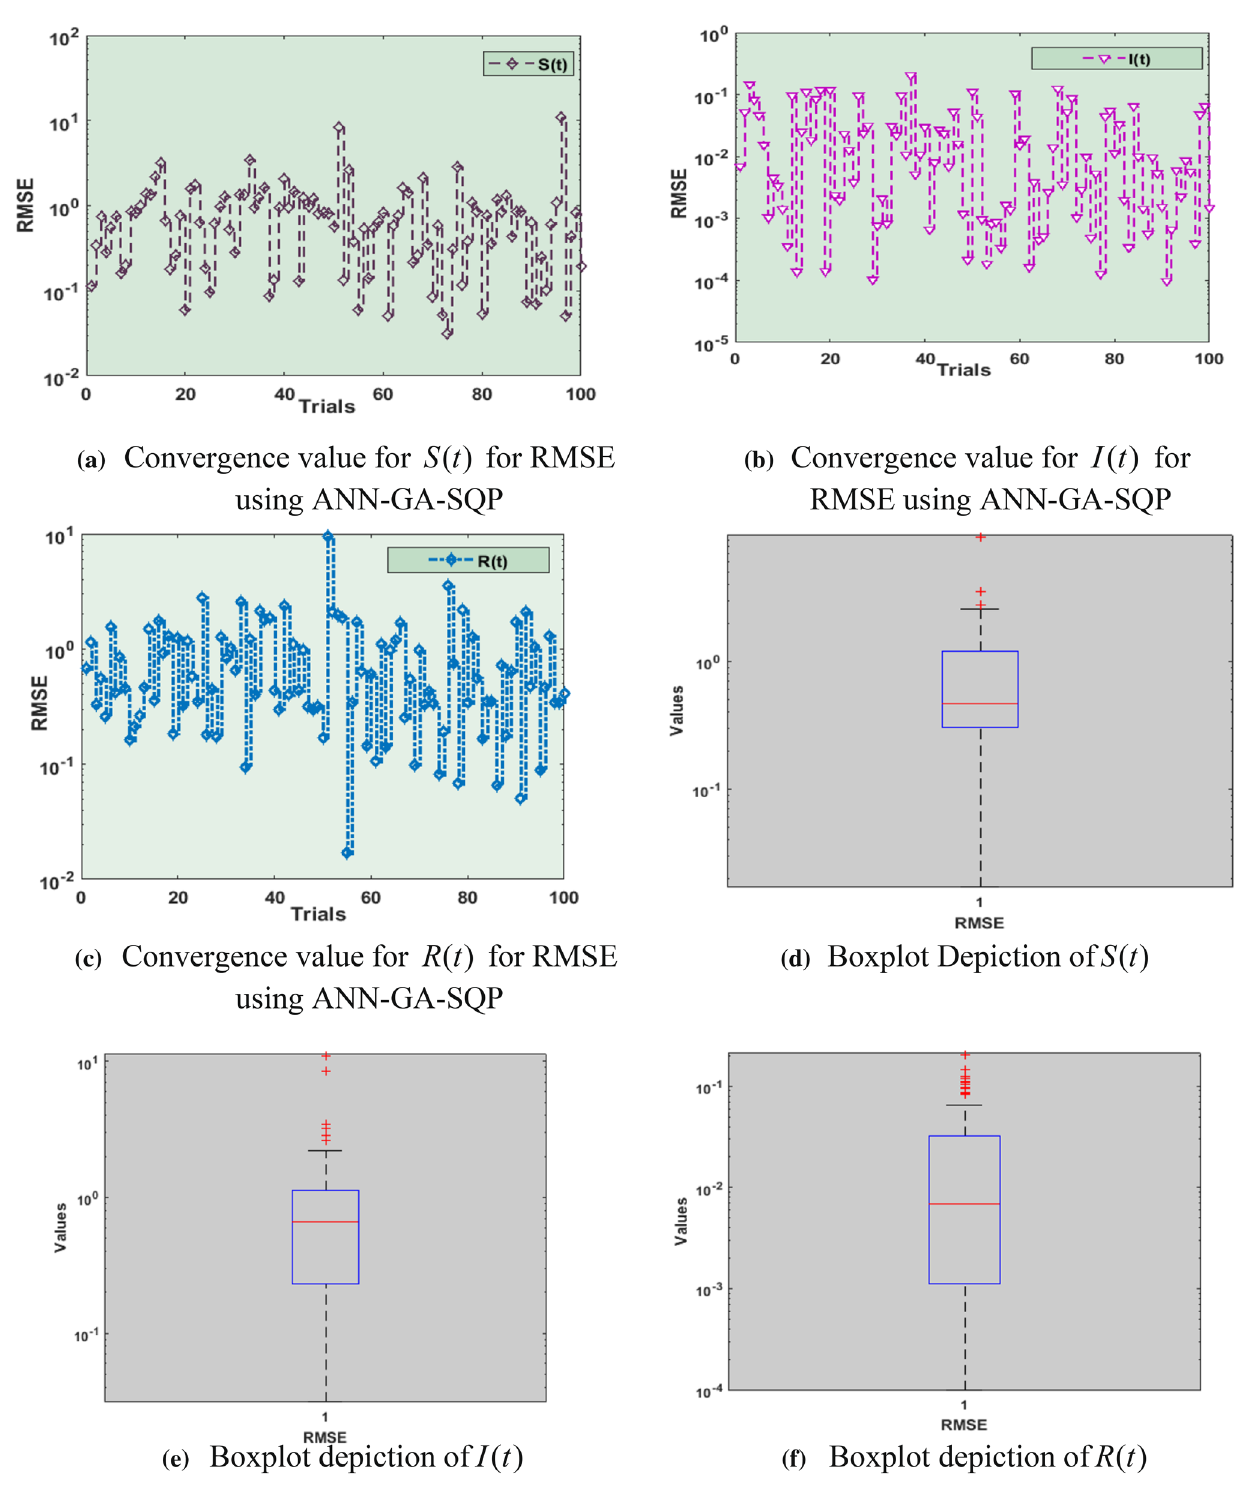
Fig. 6 Performance analysis of RMSE for S ( t ), I ( t ) , R ( t ) with boxplots, including 5 neurons using ANN-GA-SQP for COVID-19 SIR